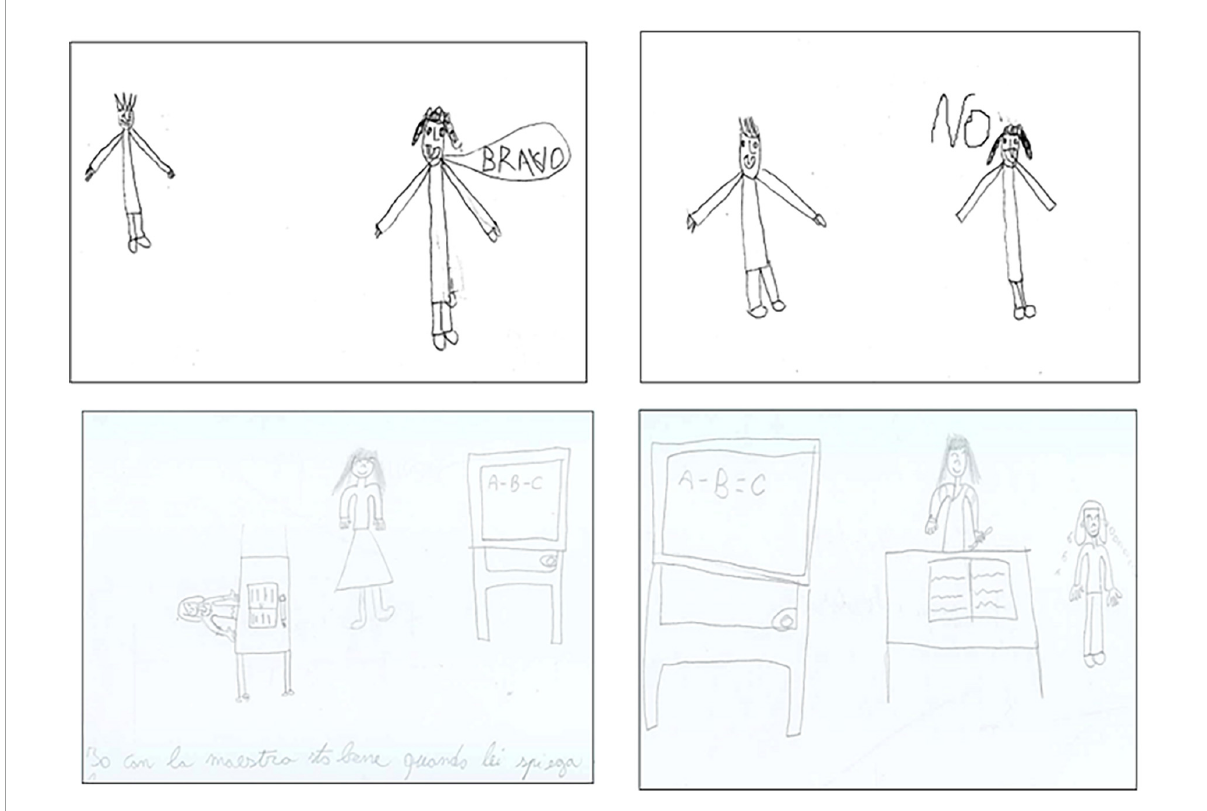
FIGURE2 Examples of lower valorization of the teacher in Distress. Drawings in the (Upper section) are by the same boy (3rd grade), those in the (Bottom section) by the same girl (5th grade): to reduce the teacher’s comparative value the first employed a simple strategy (enhanced self-dimension), while the second used a more complex pictorial plan: she interchanged the respective positions of the figures, showing the teacher’s entire body in the Wellness (caption says: “I feel fine with the teacher when she explains”), and her own entire body in